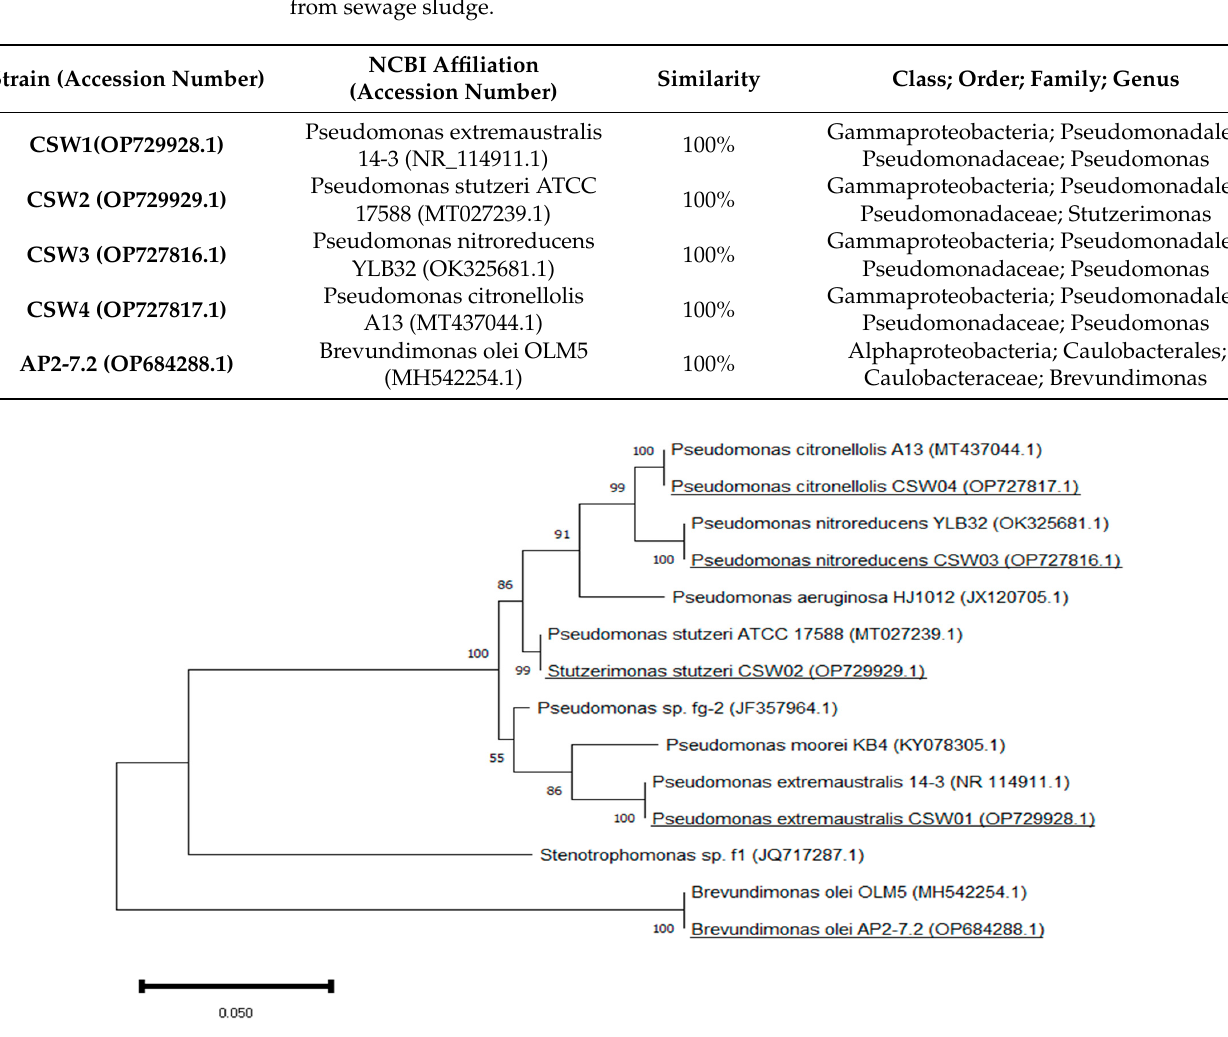
Figure 1. Maximum Likelihood tree based on 16S rRNA genes showing the relationships between the strains isolated from the enrichment culture (underlined) using other strains of the same species as a reference. Bootstrap values are expressed as percentages of 1000 replicates. The same branches representation was recovered by the neighbor-joining and maximum-parsimony algorithms. The scale bar indicates 0.050 substitutions per nucleotide position in the 16S rRNA gene sequences